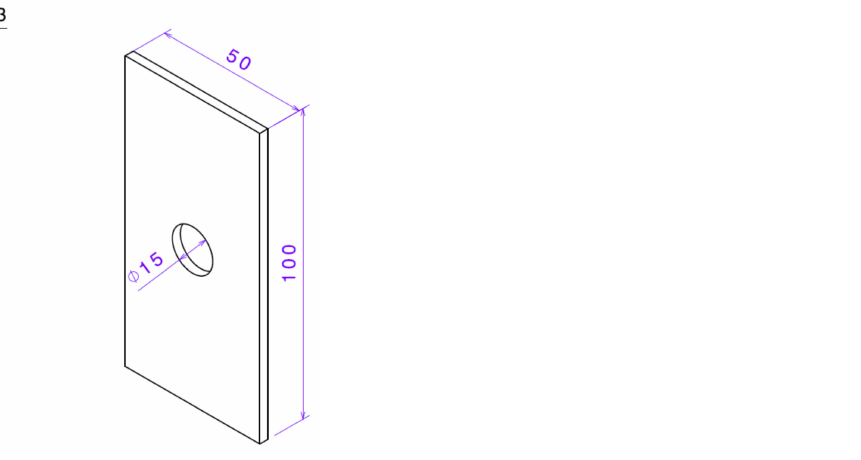
Figure 1. Drawing of the specimen with 15 mm notch diameter (dimensions are in mm). Table 1. Loading condition for 1045 steel specimens with different notch diameters